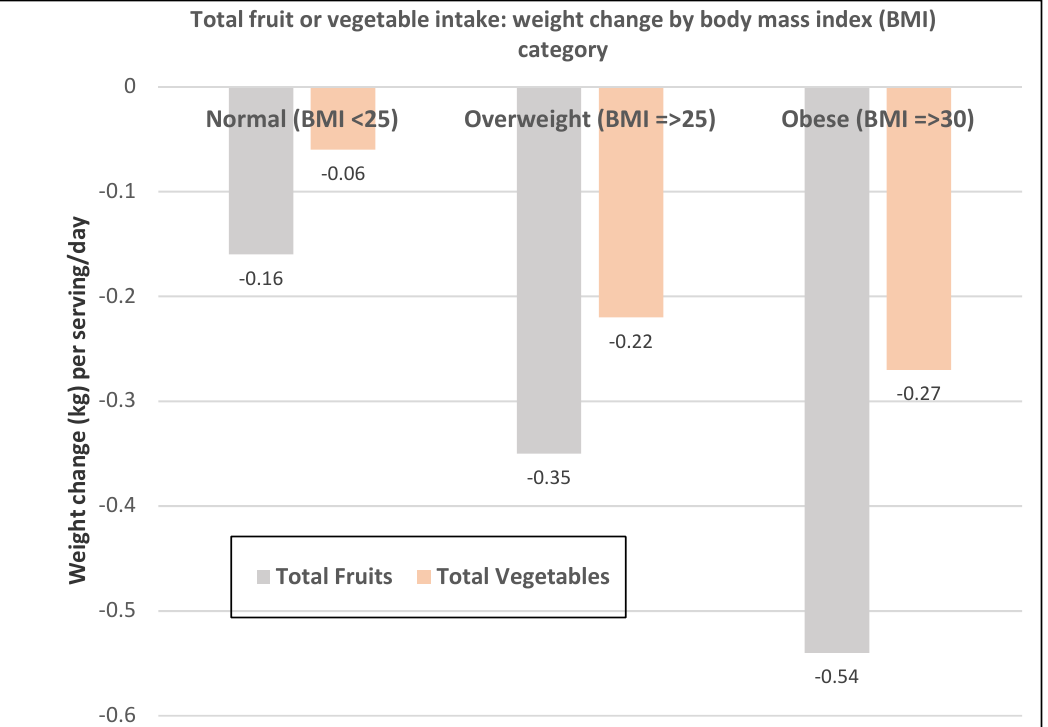
Figure 4. Multivariate adjusted association between total fruit and total vegetable intake per serving/day and pooled mean weight change for all NHS and NHS II women per 4-year period [18].